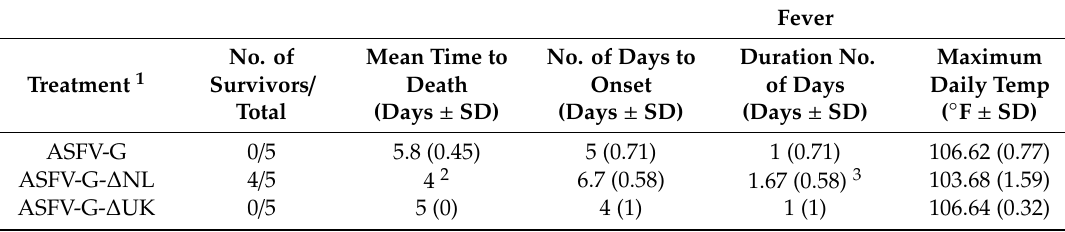
Table 1. Swine survival and fever response in animals infected with mutant viruses ASFV-G- Δ NL or ASFV-G- Δ UK compared with those infected with parental ASFV-G.